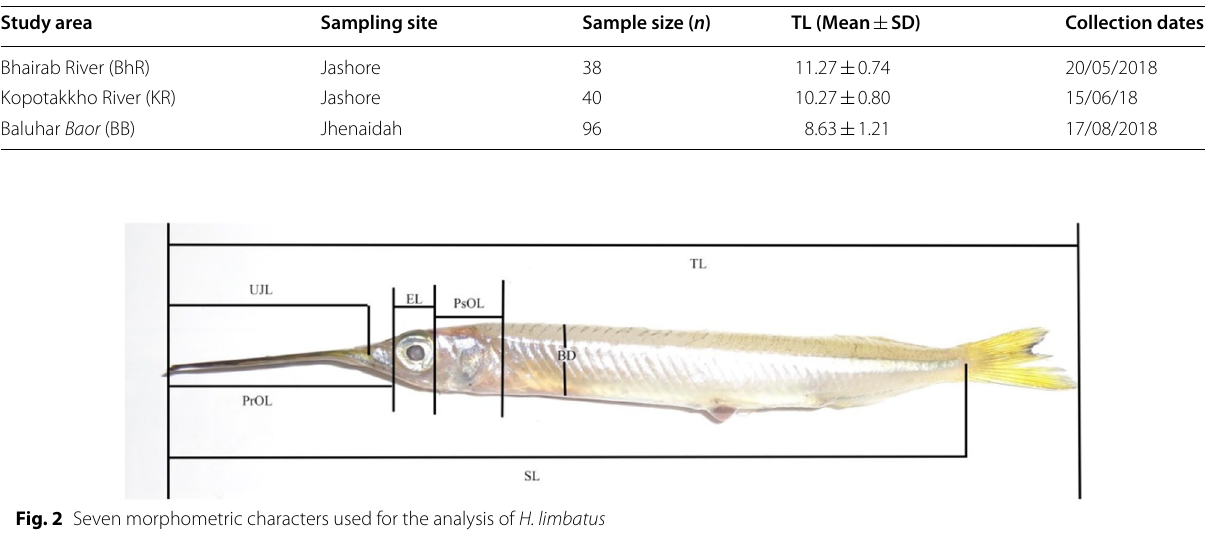
Table 1 Sampling details of H. limbatus collected from three study spots in Southwestern Bangladesh